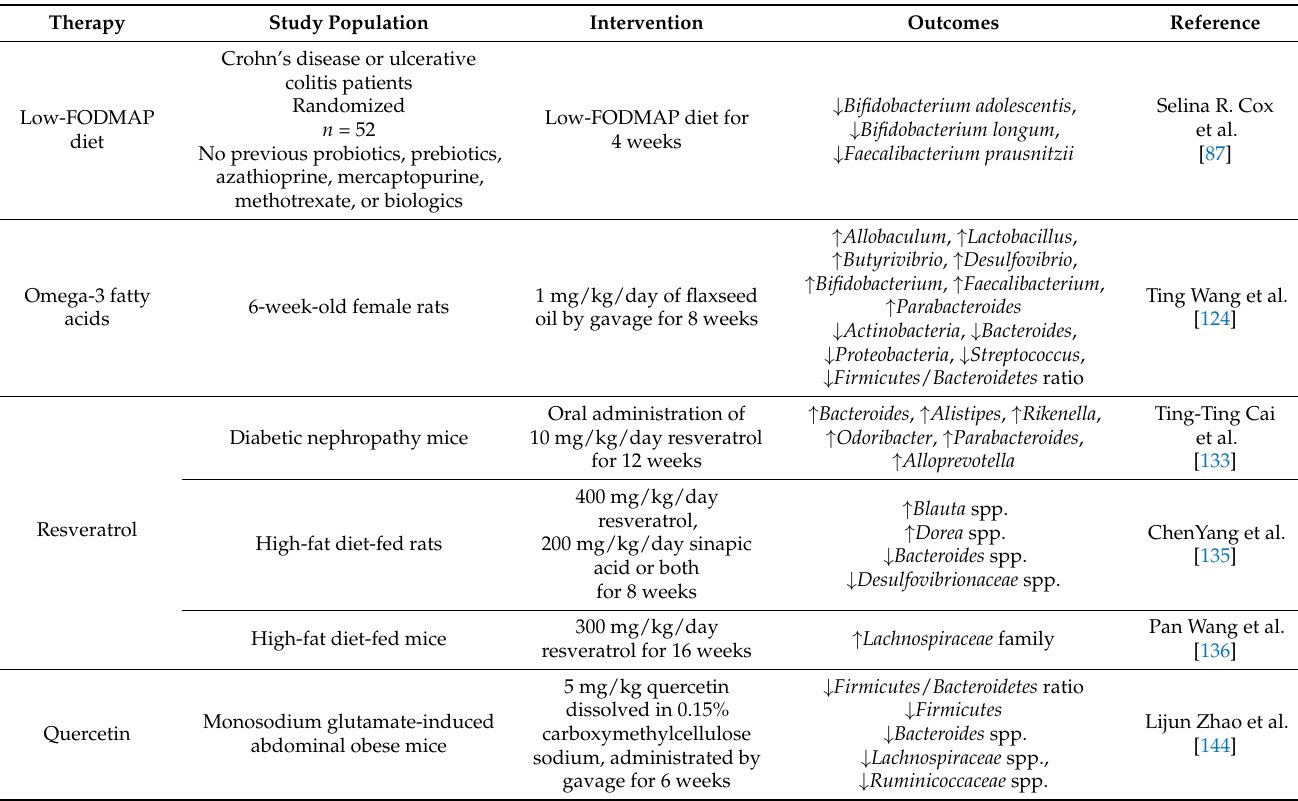
Table 1. The effects of low-FODMAP diet and biologically active compounds on the intestinal microbiome.